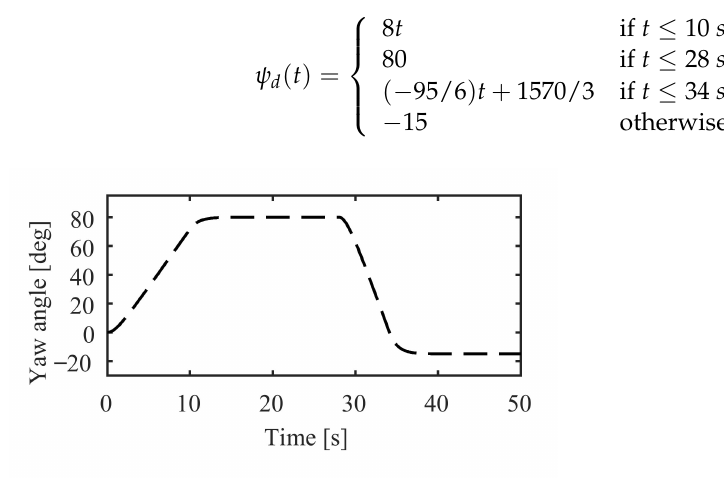
Figure 5. The desired yaw angle